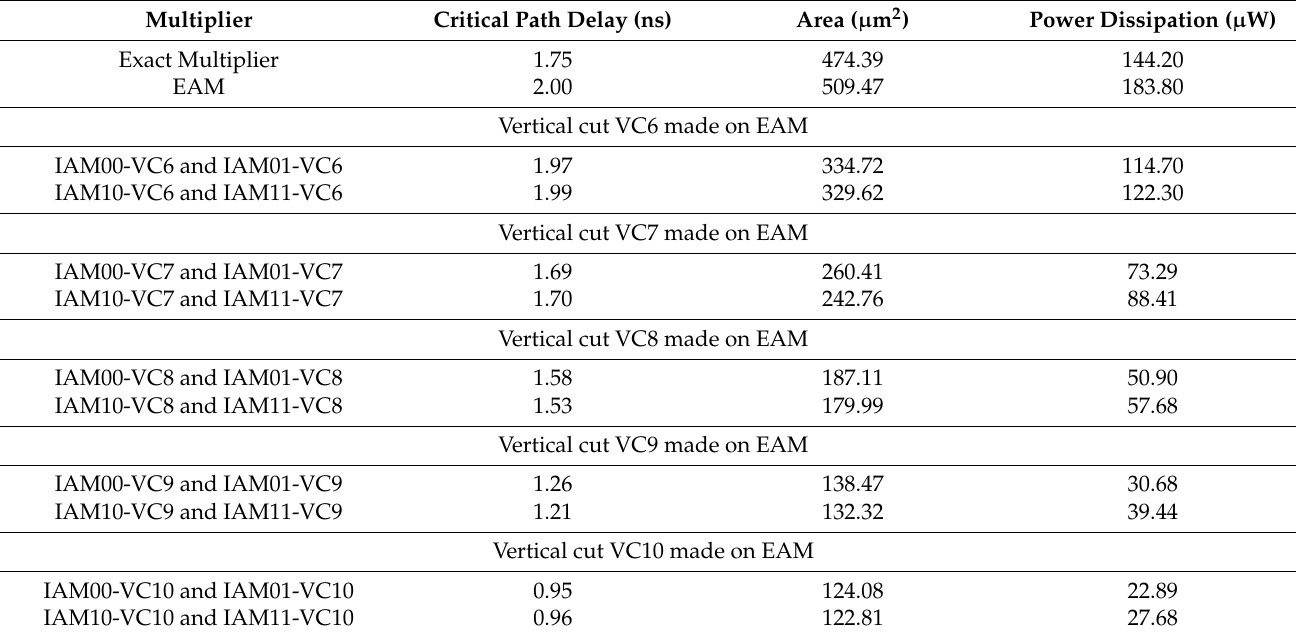
Table 2. Standard design metrics of exact and inexact multipliers implemented using a 32/28 nm CMOS standard digital cell